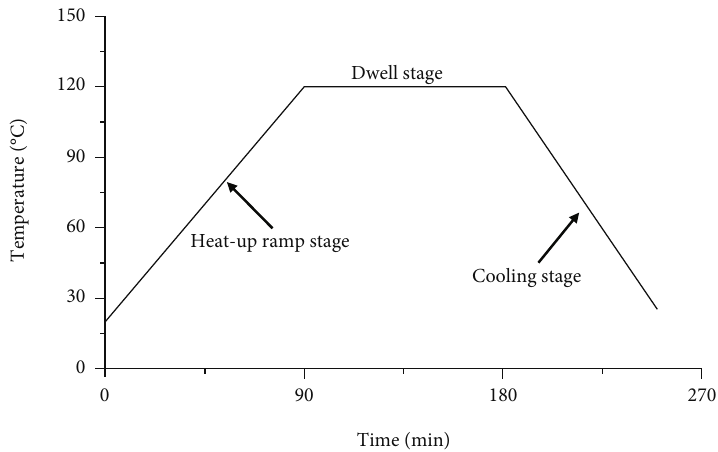
Figure 6: Cure cycle of USN 10000/T300 prepreg from